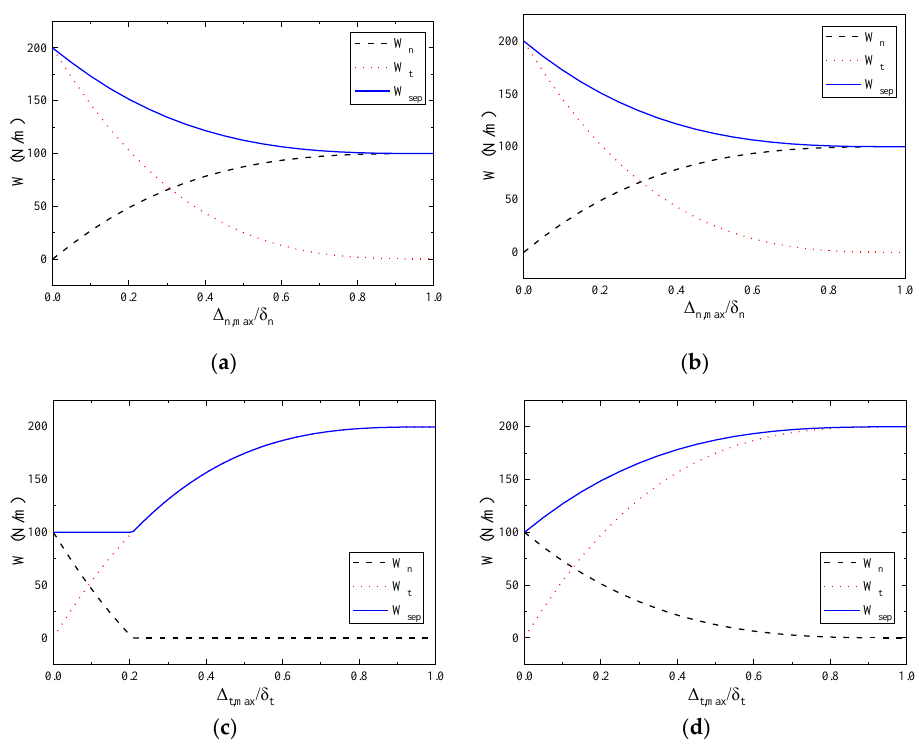
Figure 8. Variation of the work-of-separation for the case of 𝜙 𝑛 < 𝜙 𝑡 ( 𝜙 𝑛 = 100 N/m and 𝜙 𝑡 = 200 N/m ): non-proportional Path 1 ( a , b ); or non-proportional Path 2 ( c , d ). PPR model ( a , c ); SPPR model ( b , d ).